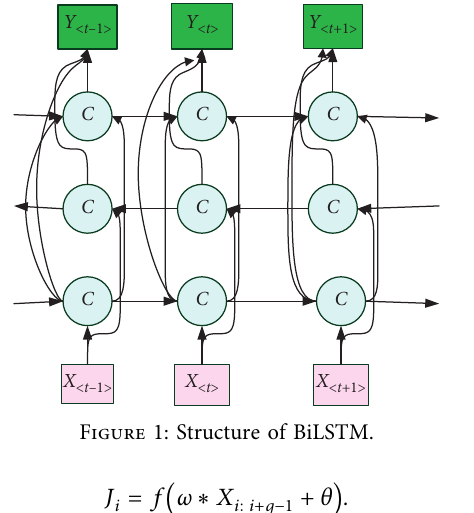
Figure 1: Structure of